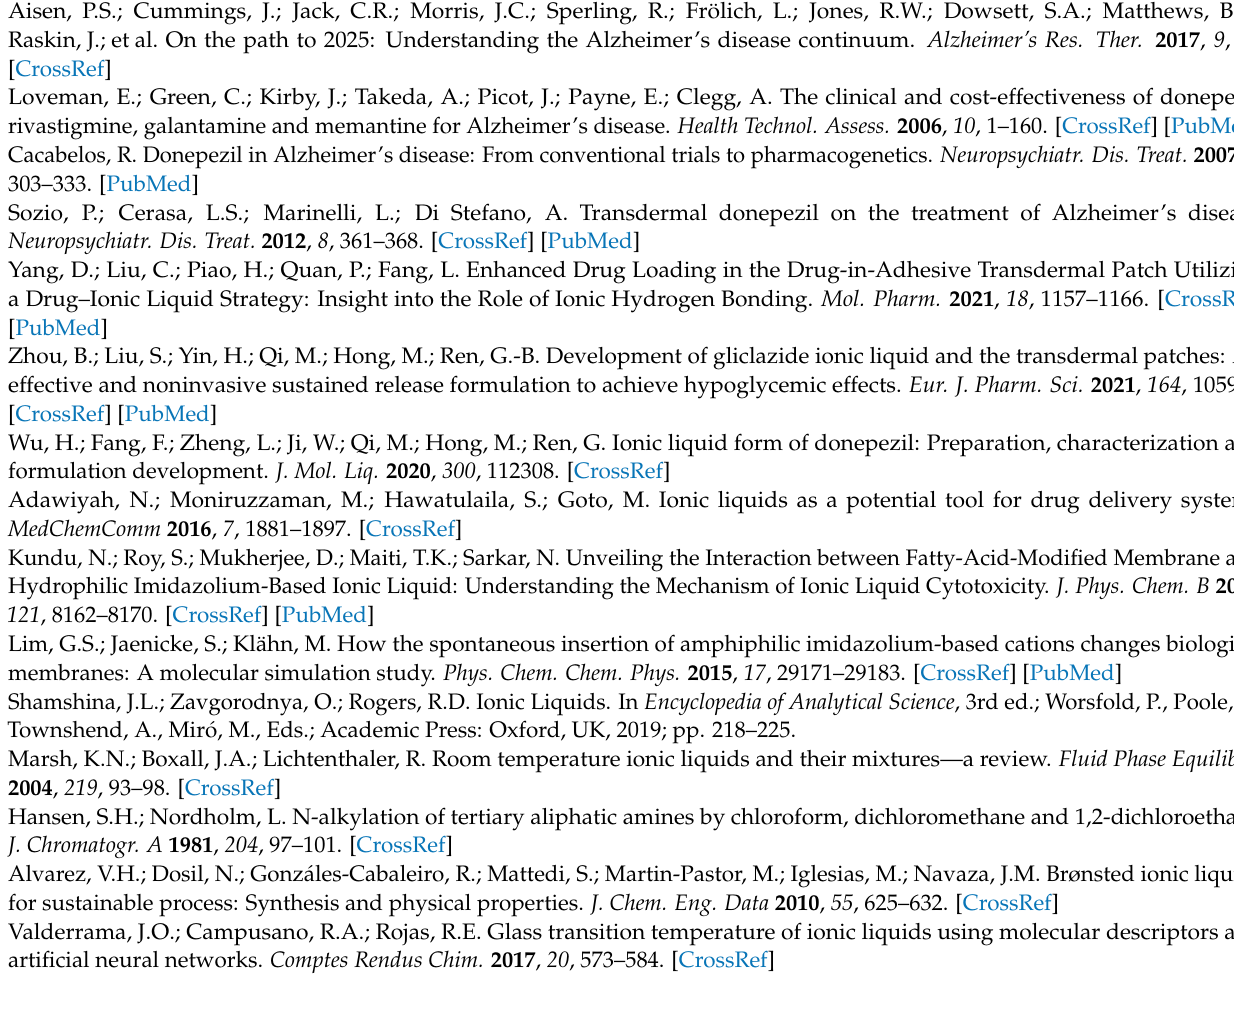
Figure S9. 1 H NMR spectrum of DPZ-sebacic acid IL. Figure S10. 1 H NMR spectrum of DPZ-suberic acid IL. Figure S11. 1 H NMR spectrum of DPZ-succinic acid IL. Figure S12. 1 H NMR spectrum of DPZ-tartaric acid IL. Figure S13. 1 H NMR spectrum of DPZ-alpha keto glutaric acid